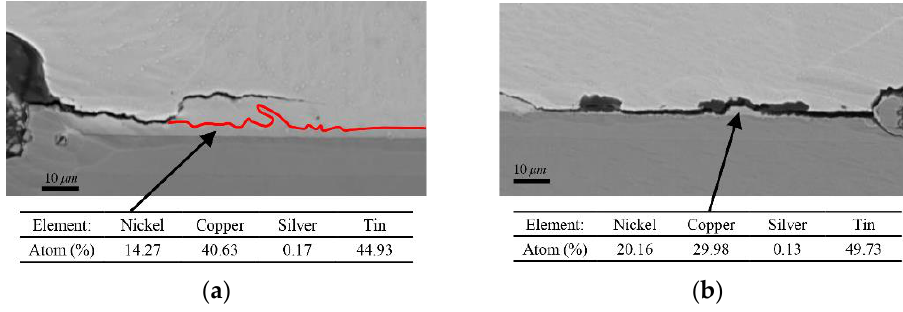
Figure 6. EDX results at the crack area of ( a ) Sample 1#L and ( b ) Sample 1#R. Figure 5. Interfacial failure modes of three samples. ( a ) Sample 1#L, ( b ) Sample 1#R, ( c ) Sample 2#L,